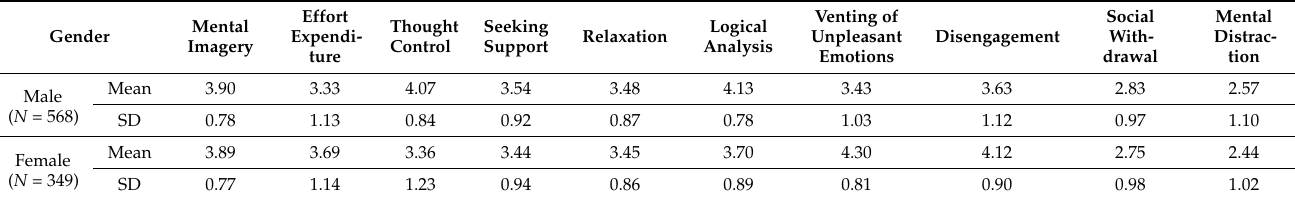
Table 3. First-order coping scores relative to gender.